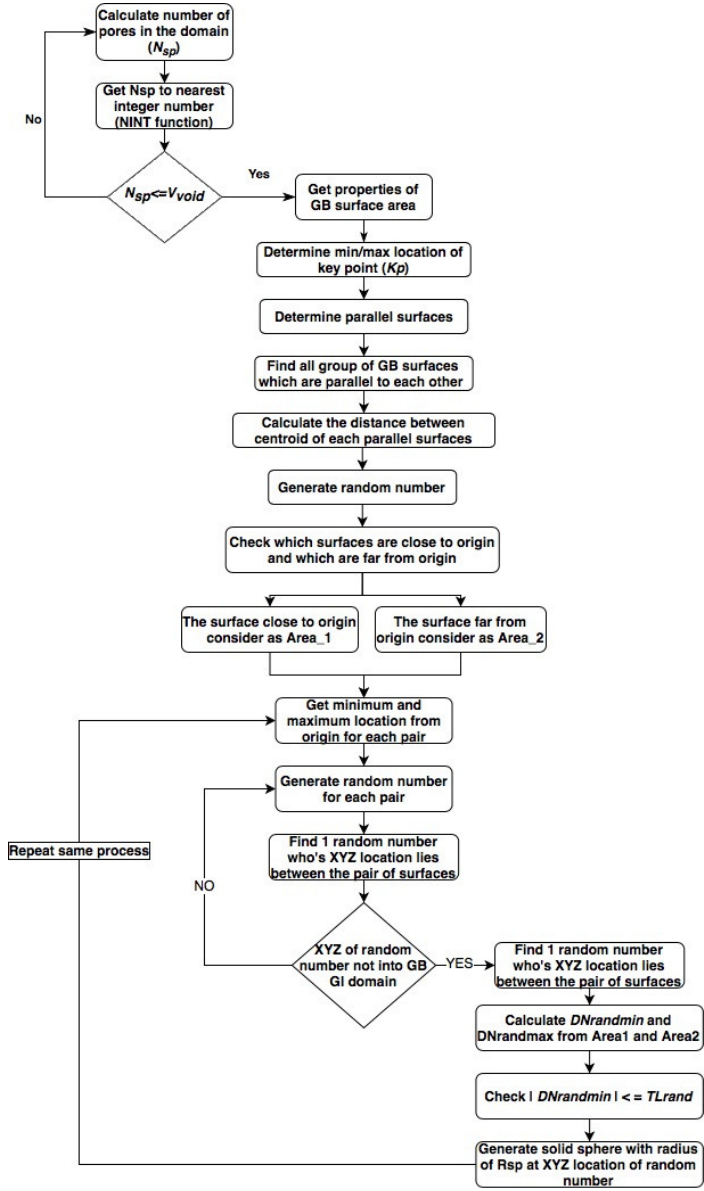
Figure 6. Flowchart of numerical methodology for the random generation of pores.